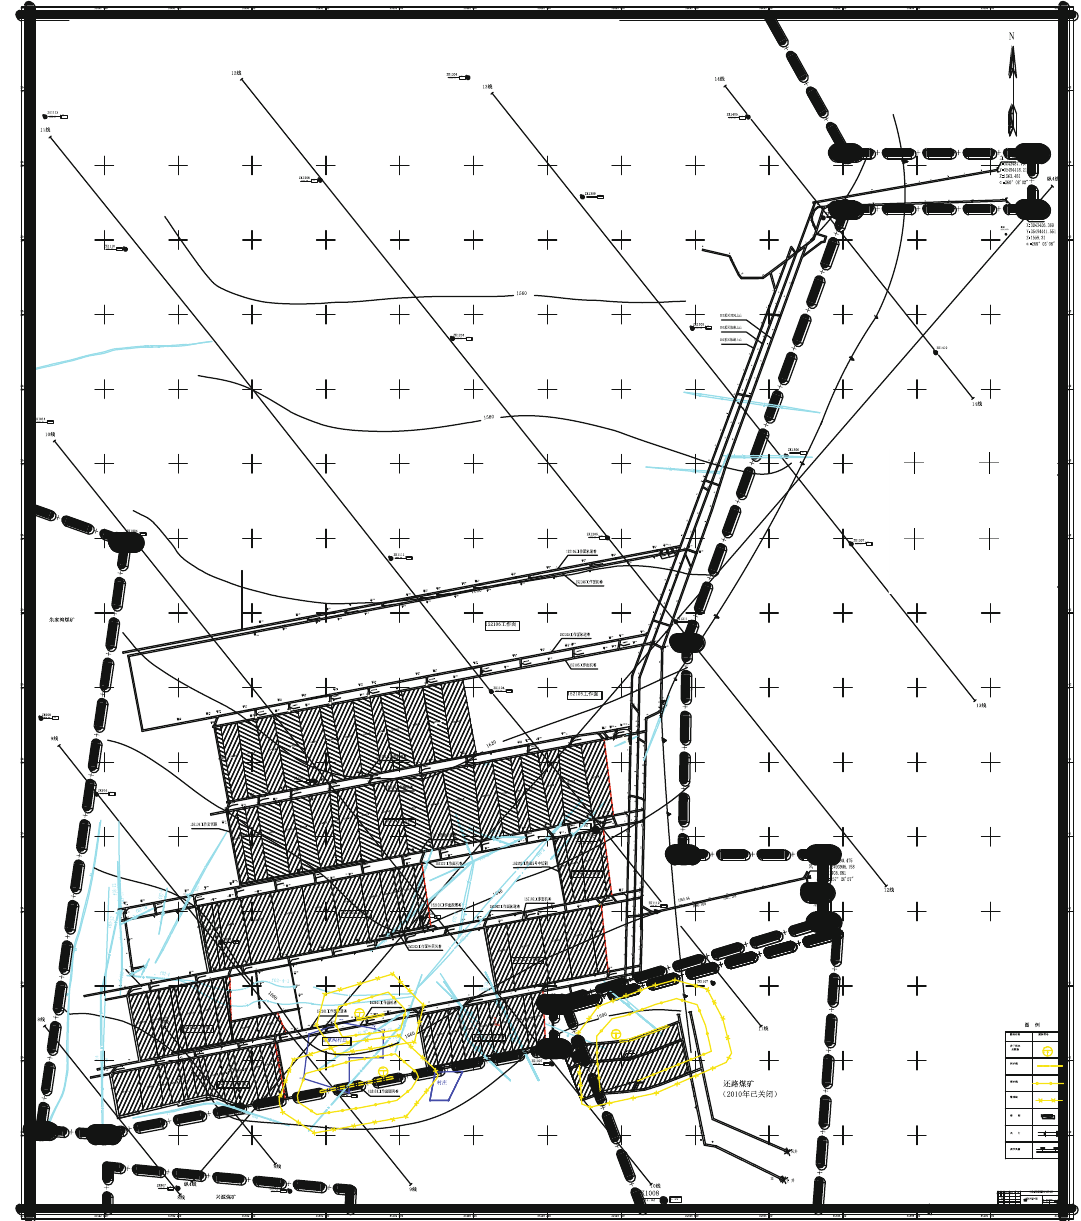
Figure 1: Excavation plan of 101 mining area of Changling coal